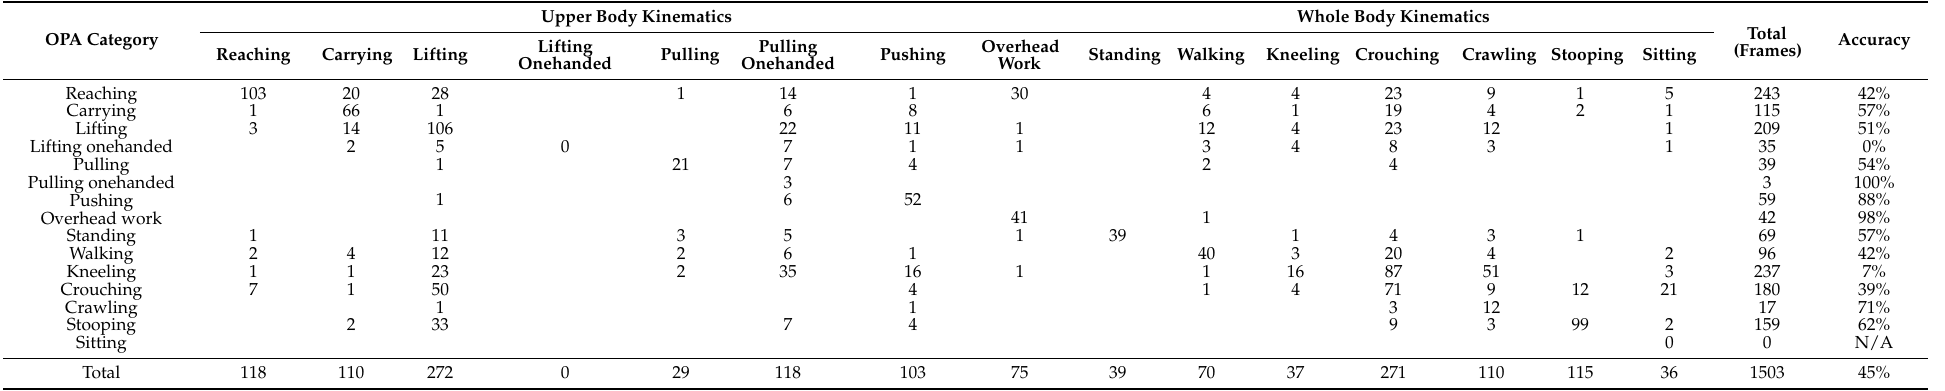
Table 6. Accuracy of the top 3 OPA predictions during simulated work tasks. A confusion matrix showing the accuracy of the best three CNN predictions of OPAs in simulated work tasks. If there was a correct prediction in the best three outcomes, the correct one was counted. Otherwise, the first outcome of the best three predictions was counted. Cells in the left-hand column represent OPA categories in tasks and cells in the second row represent the best three predicted activities. The best three CNN predictions of each frame were taken for analysis. Cells on the main diagonal and off-diagonal indicate the number of correct and incorrect prediction of each activity. The two right-hand columns represent the total frame and CNN best three prediction accuracies of each OPA, respectively. The cell at the bottom-right corner indicates the average accuracy of best three CNN